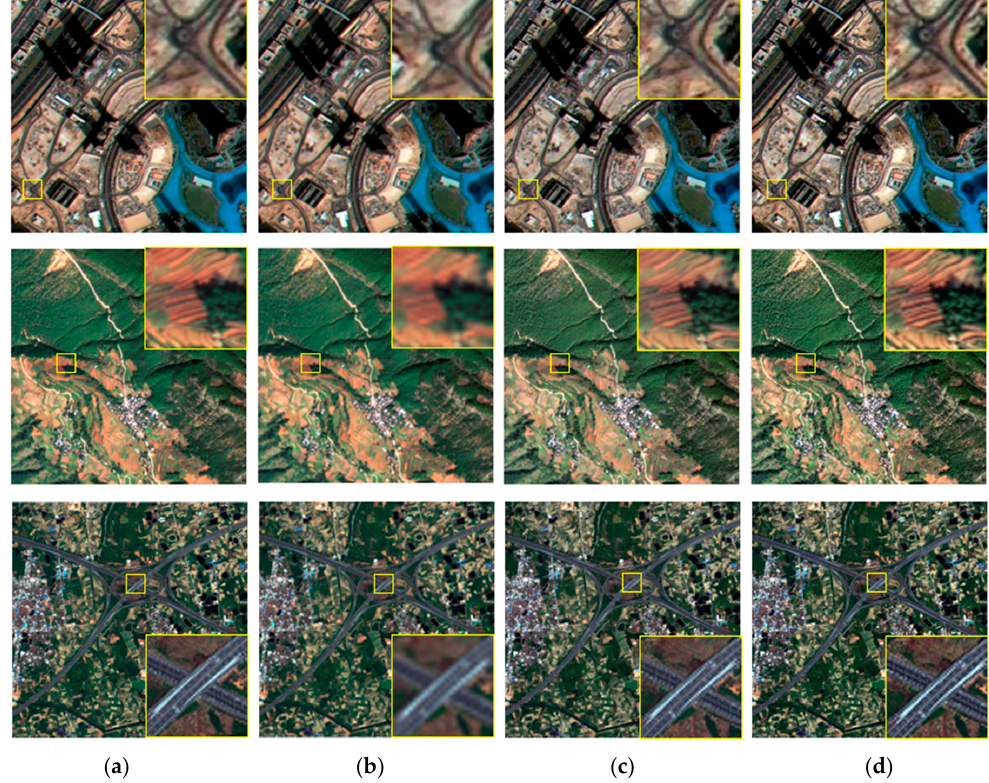
Figure 6. Simulation results of multi-spectral image ( a ) Original remote-sensing image; ( b ) Bicubic; ( c ) SRCNN; ( d ) AMDE-SR. ( c ) SRCNN; ( d ) AMDE-SR. Table 1. The Objective Evaluation Index Results of Different SR Methods. Table 1. The Objective Evaluation Index Results of Different SR